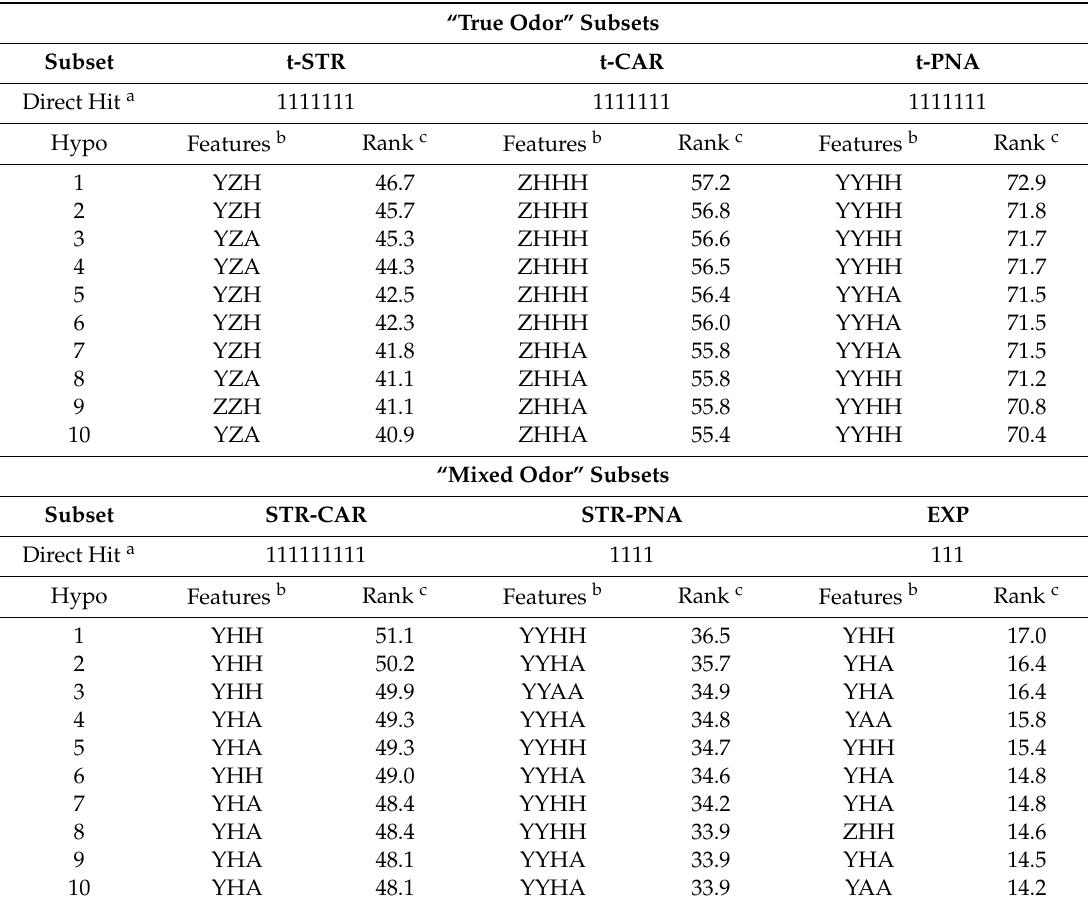
Table 5. Details of the features and ranks of the top ten hypotheses generated using HipHop for each training